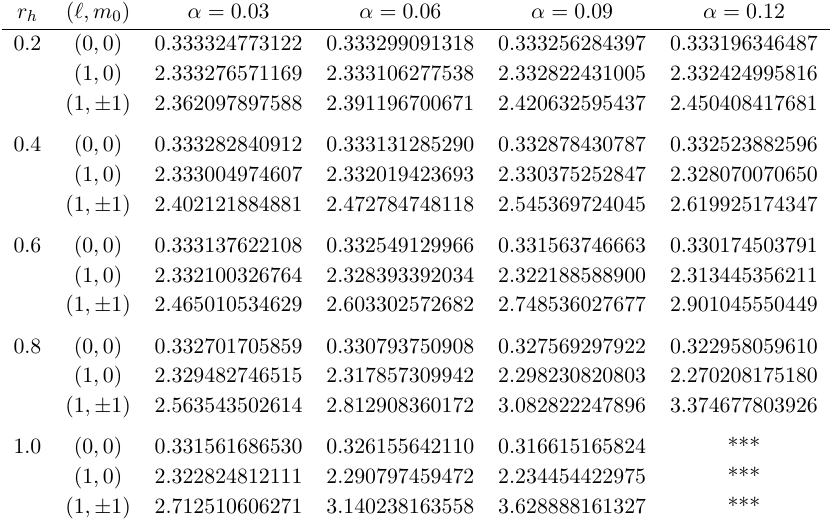
Table 10 . Angular eigenvalues λ of the ARNAdS black hole with Λ = − 3 and Q = 0 . 7 .